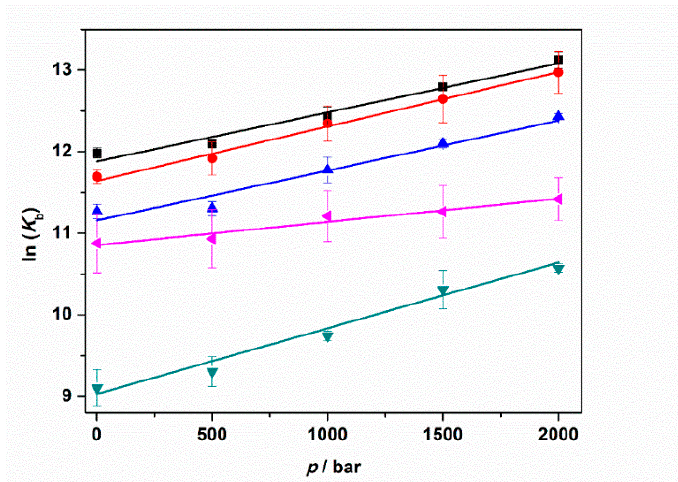
Figure 6. Plots of ln( K b ) vs. pressure ( p ) for the complex formation between tRNA and ThT in the absence (black squares) and in the presence of 150 mM NaCl (red circles), 1 mM MgCl 2 (blue triangles), 1 mM MgSO 4 (reversed dark cyan triangles), and 1 mM Mg(ClO 4 ) 2 (tilted magenta triangles). All the experiments were performed in 20 mM tris-HCl buffer, 40 mM KCl, pH 6.9. The solid lines represent linear fits to the experimental data. From the slopes of ln( K b ) vs. p , the binding volumes, ∆ V b , can be determined (Equation (1)).